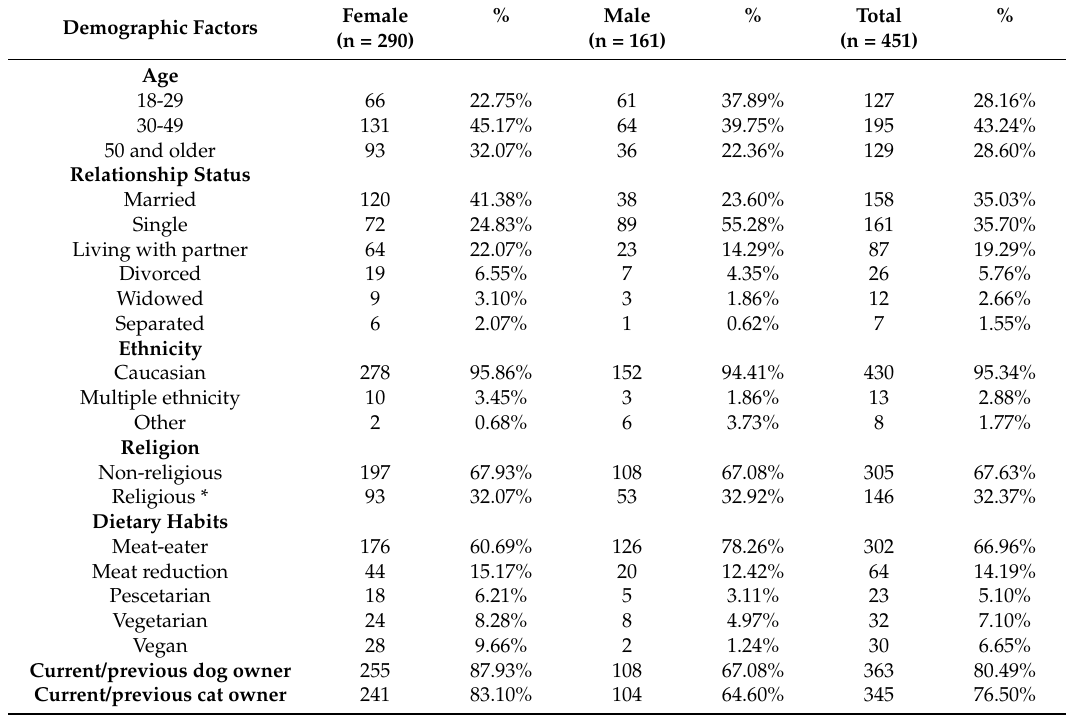
Table 1. Descriptive statistics regarding the age, gender, relationship status, ethnicity, religious beliefs, dietary habits and pet ownership experience of the respondents (n and